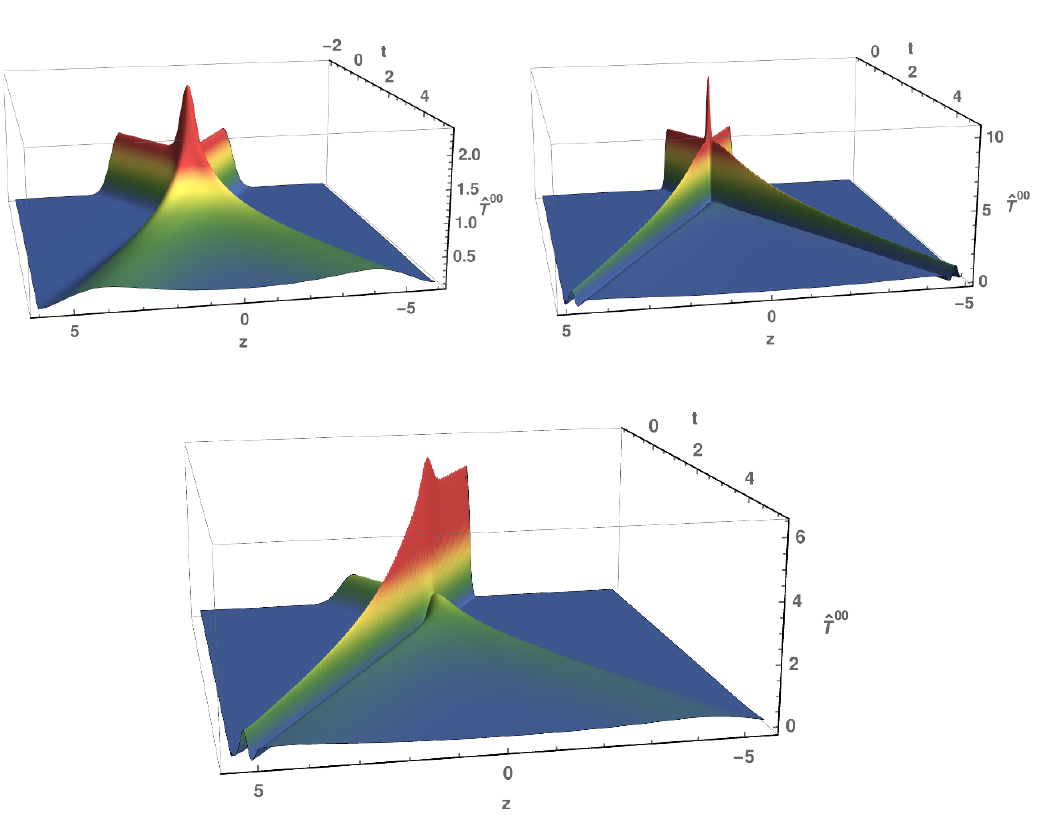
Figure 2 . The energy density b T 00 ( t; z ) plotted as a function of time t and longitudinal position z for symmetric collisions with shock width w (cid:6) = 0 : 35 =(cid:22) (upper left) and w (cid:6) = 0 : 075 =(cid:22) (upper right), and the corresponding asymmetric collision (bottom) involving shocks of widths ( w (0 : 075 =(cid:22); 0 : 35 =(cid:22) ). All shocks have equal transverse energy density (cid:22) 3 .